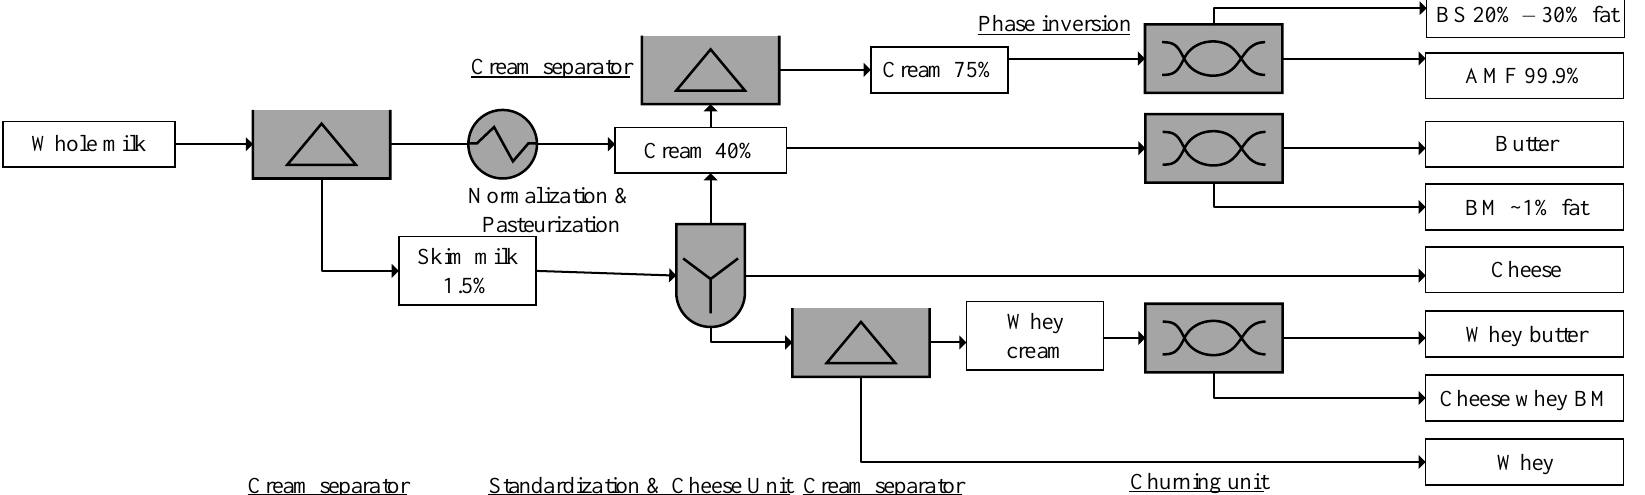
Figure 1. Buttermilk (BM) and beta serum (BS) production process [26]. AMF, anhydrous milk fat. % indicates the fat content.